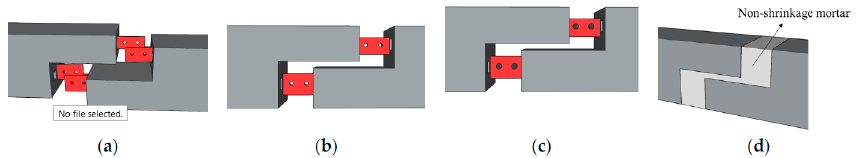
Figure 4. Construction process of proposed precast concrete modular beam system: ( a ) inserting an I-shaped steel plate into a U-shaped steel plate; ( b ) splice connection between steel plates; ( c ) bolt connection between steel plates; ( d ) injection of non-shrink